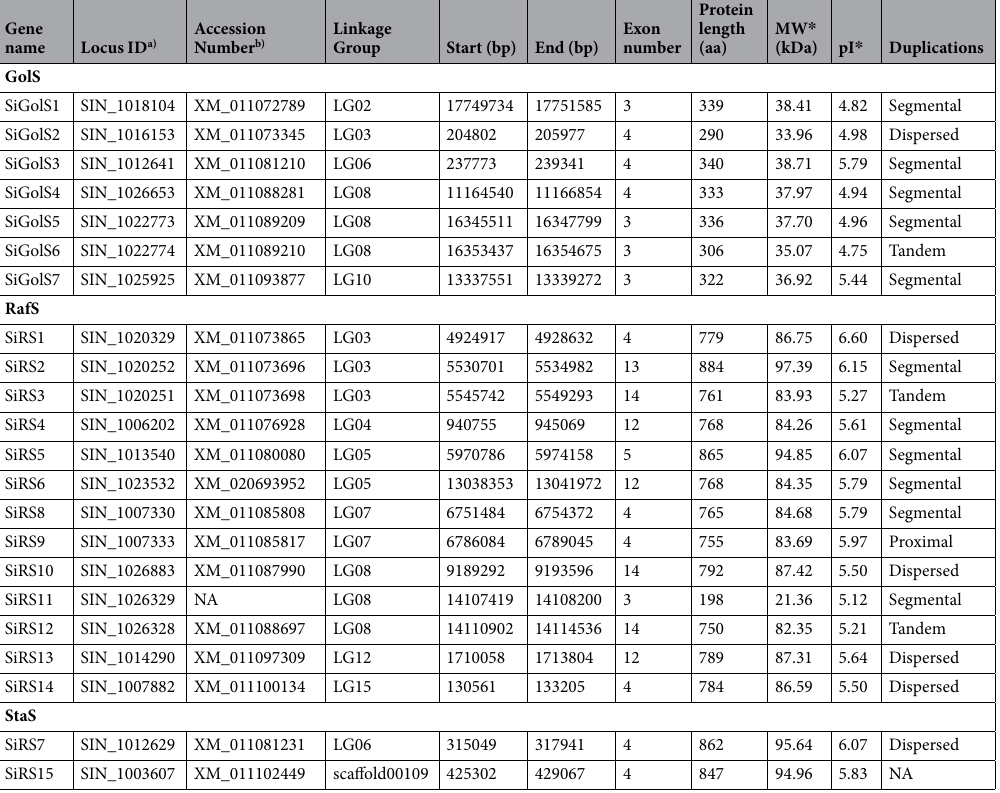
Table 1. Raffinose biosynthesis related genes in Sesame. a) Locus ID was adopted from Sinbase ( Sesamum indicum genome database, http://ocri-genomics.org/Sinbase/index.html). b) Accession Number was adopted from NCBI (The National Center for Biotechnology Information, https://www.ncbi.nlm.nih.gov/). * MW: Molecular Weight; pI: Isoelectric point; NA: not available.